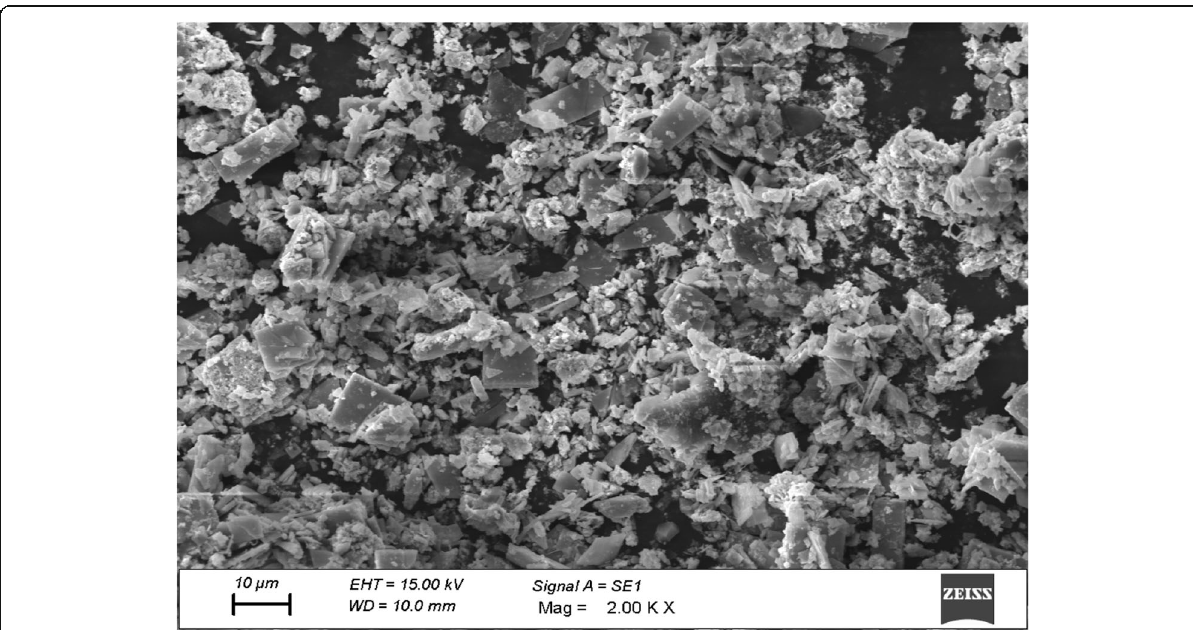
Fig. 2 Scanning electron micrograph of chemically synthesized silver nanoparticles